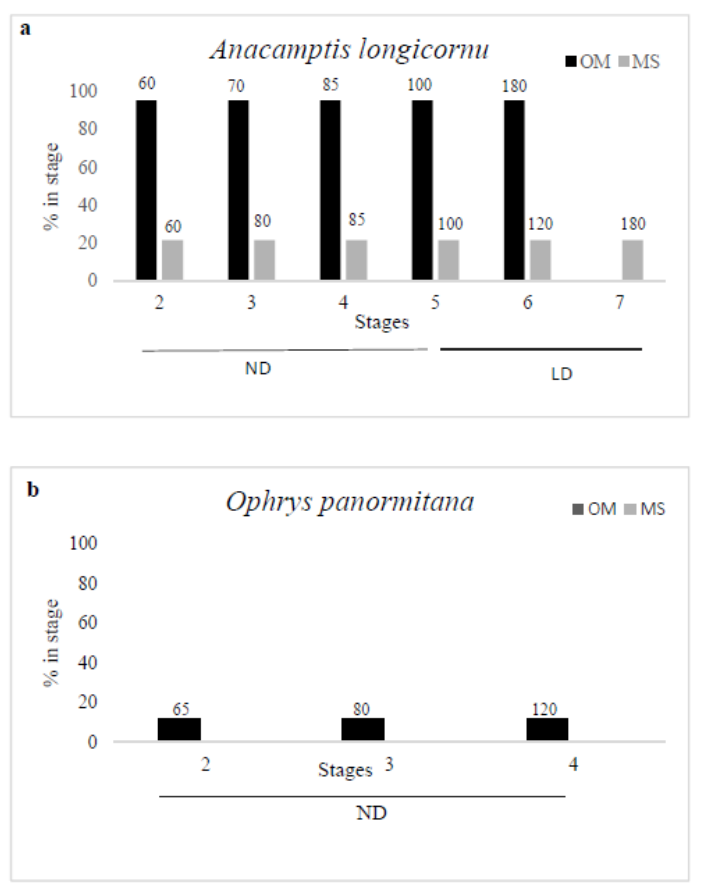
Figure 5. Effect of culture medium and photoperiod on in vitro seedling development stage of Ancamptis longicornu ( a ) and Ophrys panormitana ( b ). Numbers on columns indicate days after sowing. ND—neutral day; LD—long day.